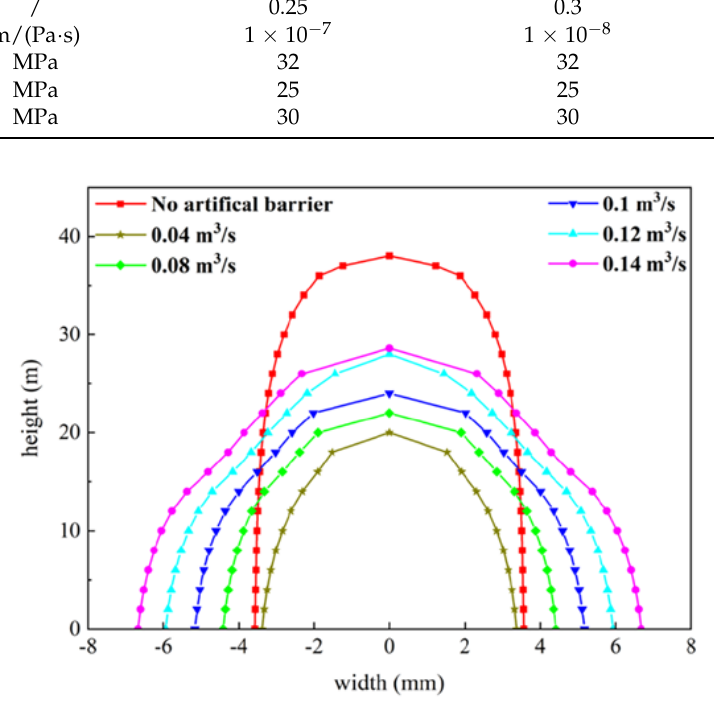
Figure 14. Fracture morphology under different pumping rate.